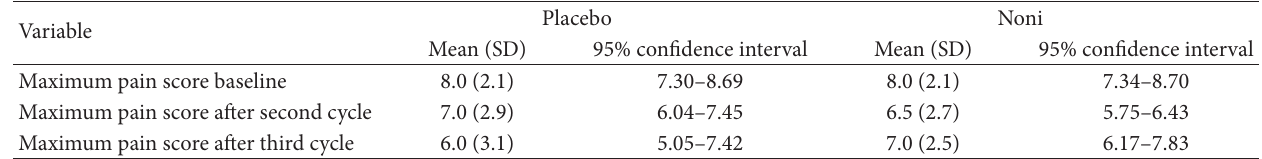
T 3: Comparison of the effects of Noni versus placebo on pain score.